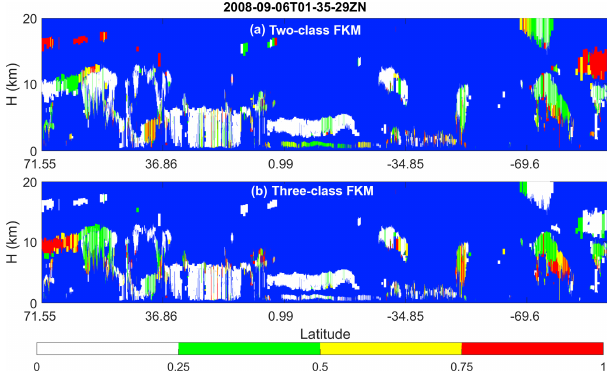
Figure 5. For the same data as shown in Fig. 4; the upper panel (a) shows the confusion index for two-class CAD FKM , and the lower panel (b) shows the confusion index for three-class CAD FKM . The pure blue color once again indicates those regions where no atmospheric layers were